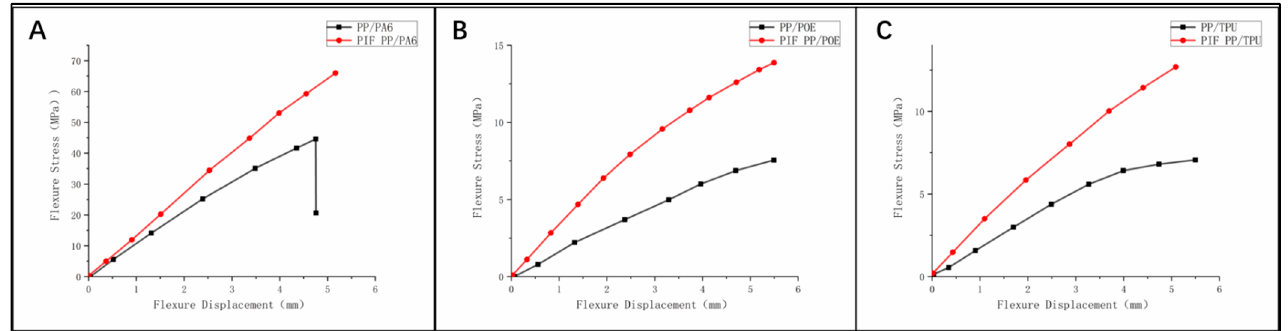
Table 4. Thermal properties of PP/TPU blends before and after PIF .